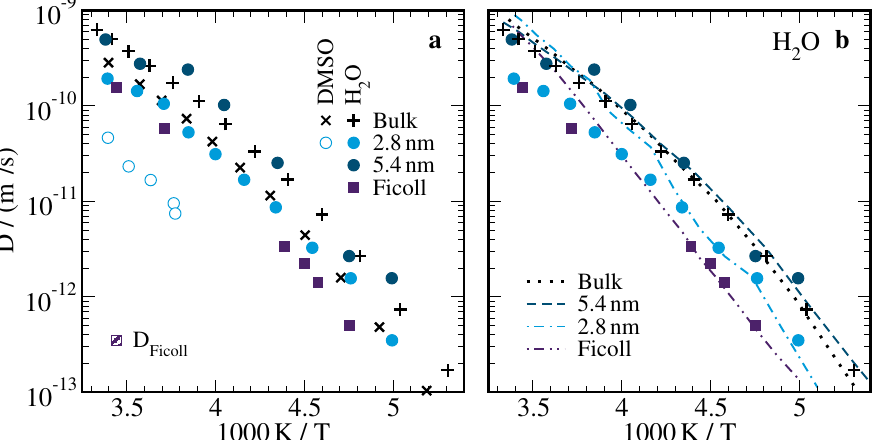
Figure 11. ( a ) Temperature-dependent self-diffusion coefficients D of the components of 66mol% H 2 O-DMSO- d 6 (H 2 O) and D 2 O-DMSO- h 6 (DMSO) solutions in the bulk, in silica pores with the indicated diameters, and in ficoll at a mass fraction of w s = 70wt%. The shaded square is the self-diffusion coefficient of ficoll. ( b ) Comparison of (symbols) the measured self-diffusion coefficients of H 2 O with (lines) D values calculated from the SLR correlation times τ of D 2 O, see Figure 8, based on the Stokes–Einstein–Debye relation Equation